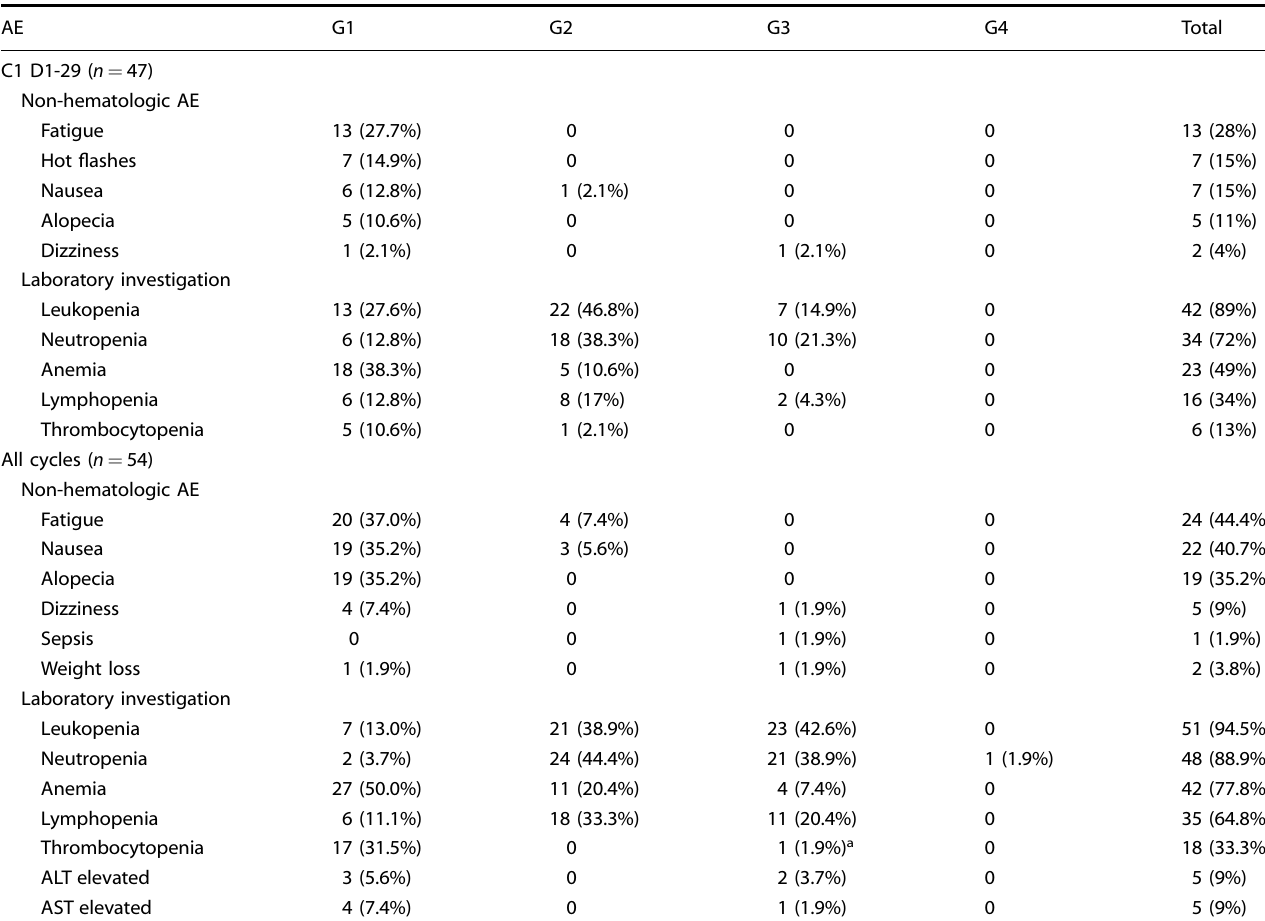
Table 2. Adverse